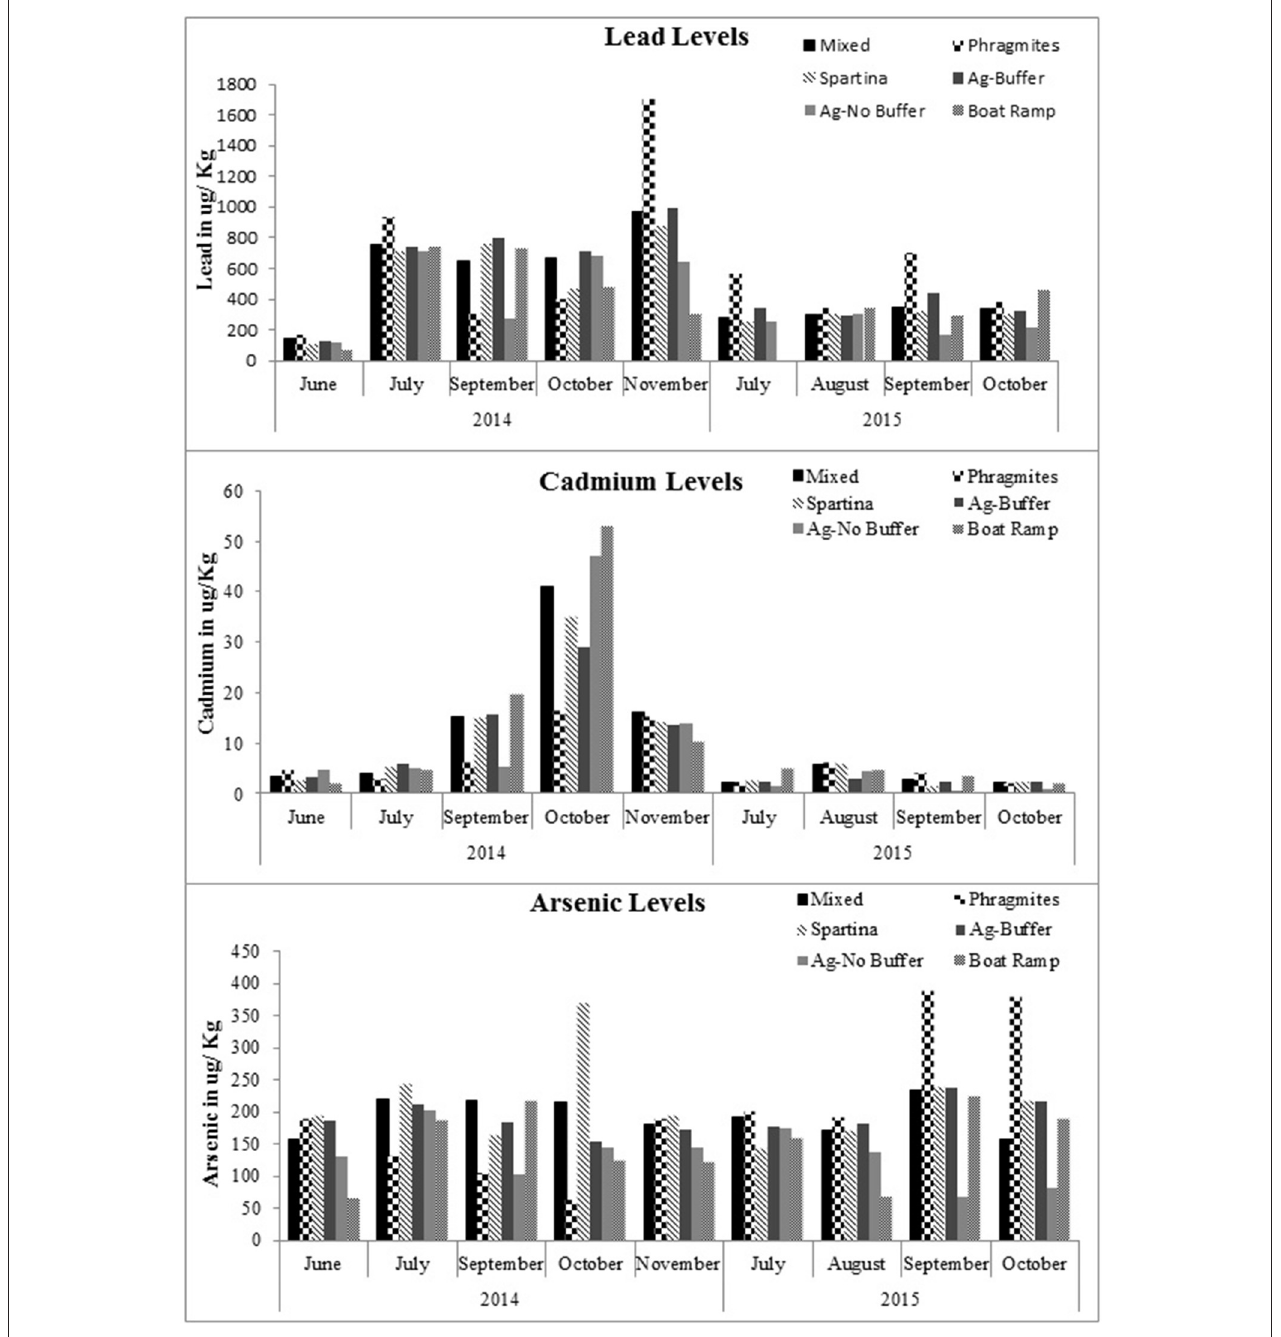
FIGURE 3 | Relationships for lead, cadmium and arsenic concentrations within the marsh soil and Phragmites leaves for the study year 2014.